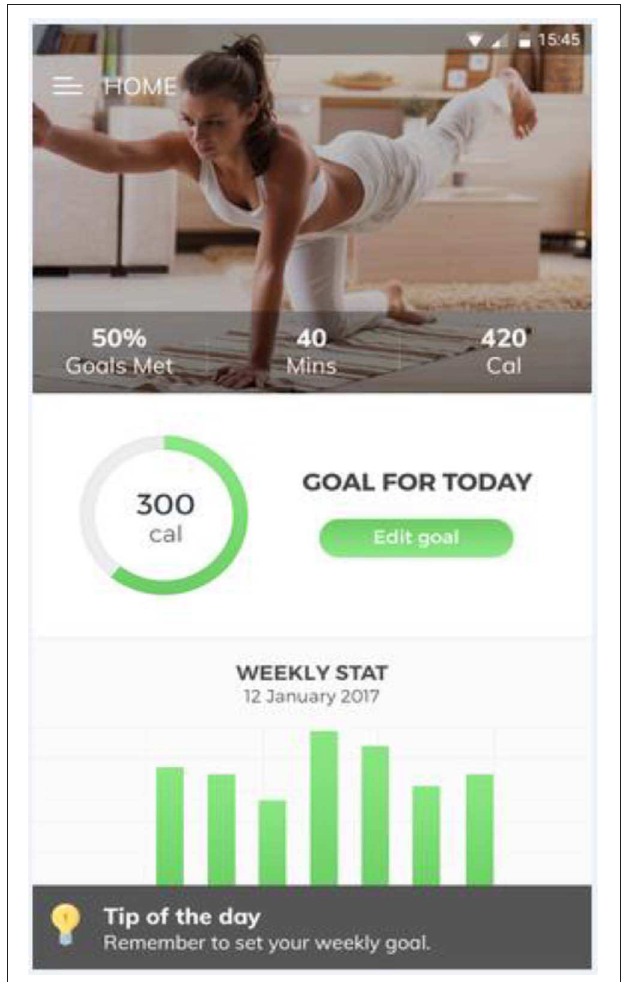
FIGURE 1 | Mobile fitness application design for encouraging home-based exercise behavior 1